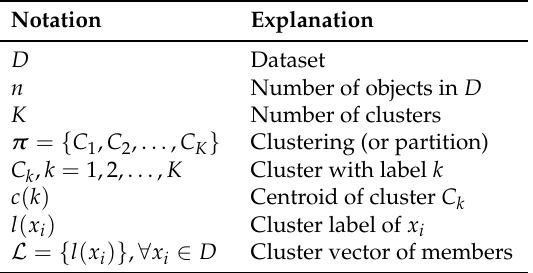
Table 1. List of notations.